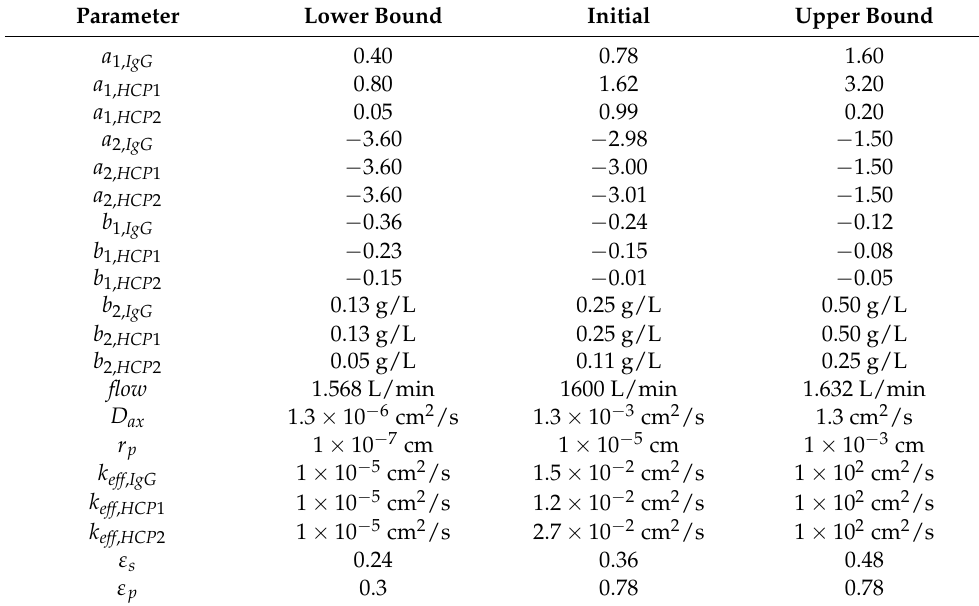
Table 1. Upper and lower limits of the varied parameters from equation in the sensitivity analysis. The parameters a 1 , a 2 , b 1 and b 2 originate from Equations (8) and (9), and describe the salt dependency of the Henry coefficient and maximum loading. D ax , r p , k eff , ε s and ε p represent the axial dispersion coefficient, the particle radius, the effective mass transfer coefficient, the voidage and the particle porosity, respectively. The parameters originate from Equations (2), (3) and (5). Parameter Lower Bound Initial Upper Bound a 1, IgG 0.40 0.78 1.60 a 1, HCP 1 0.80 1.62 3.20 a 1, HCP 2 0.05 0.99 0.20 a 2, IgG − 3.60 − 2.98 − 1.50 a 2, HCP 1 − 3.60 − 3.00 − 1.50 a 2, HCP 2 − 3.60 − 3.01 − 1.50 b 1, IgG − 0.36 − 0.24 − 0.12 b 1, HCP 1 − 0.23 − 0.15 − 0.08 b 1, HCP 2 − 0.15 − 0.01 − 0.05 b 2, IgG 0.13 g/L 0.25 g/L 0.50 g/L b 2, HCP 1 0.13 g/L 0.25 g/L 0.50 g/L b 2, HCP 2 0.05 g/L 0.11 g/L 0.25 g/L flow 1.568 L/min 1600 L/min 1.632 L/min D ax 1.3 × 10 − 6 cm 2 /s 1.3 × 10 − 3 cm 2 /s 1.3 cm 2 /s r p 1 × 10 − 7 cm 1 × 10 − 5 cm 1 × 10 − 3 cm k eff , IgG 1 × 10 − 5 cm 2 /s 1.5 × 10 − 2 cm 2 /s 1 × 10 2 cm 2 /s 1 × 10 − 5 cm 2 /s 1.2 × 10 − 2 cm 2 /s 1 × 10 2 cm 2 /s k eff , HCP 2 1 × 10 − 5 cm 2 /s 2.7 × 10 − 2 cm 2 /s 1 × 10 2 cm 2 /s ε s 0.24 0.36 0.48 0.3 0.78